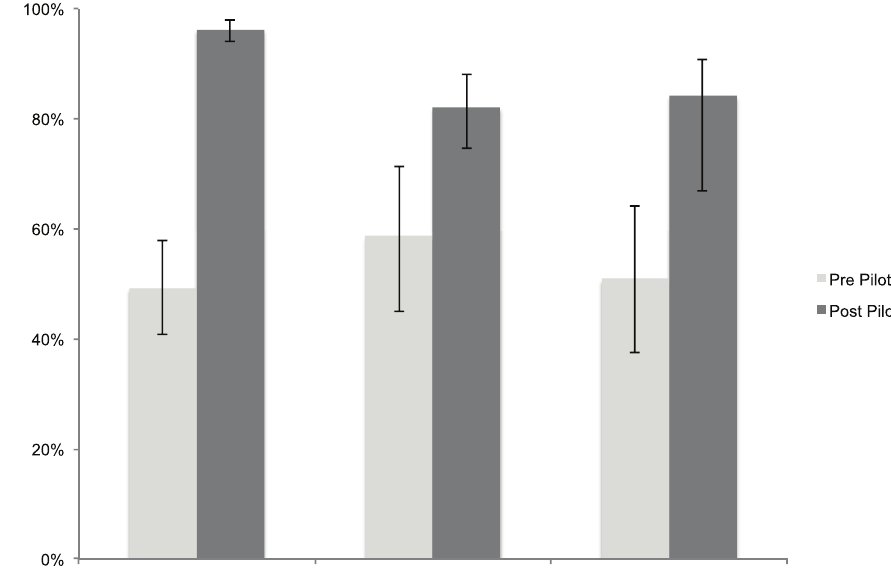
Figure 4. Pre and post-pilot identifiability. Resources (primary antibodies, organisms, and tools) were considered identifiable if they contained an accurate RRID or by using the same criteria as described in (Vasilevsky et al. , 2013). For tools (software and databases, which were not previously analyzed), these resources were considered identifiable if they contained an RRID or reported the manufacturer and version number. The total number of resources for each type is: primary antibodies pre-pilot, n = 140; primary antibodies post-pilot, n = 465; organisms pre-pilot, n = 58; organisms post-pilot, n = 139; non-commercial tools pre-pilot, n = 59; non-commercial tools post-pilot, n = 101. The y-axis is the average percent identifiable for each resource type. Variation from this average is shown by the bars: error bars indicate upper and lower 95% confidence intervals. Asterisks indicate significant difference by a z-score greater than